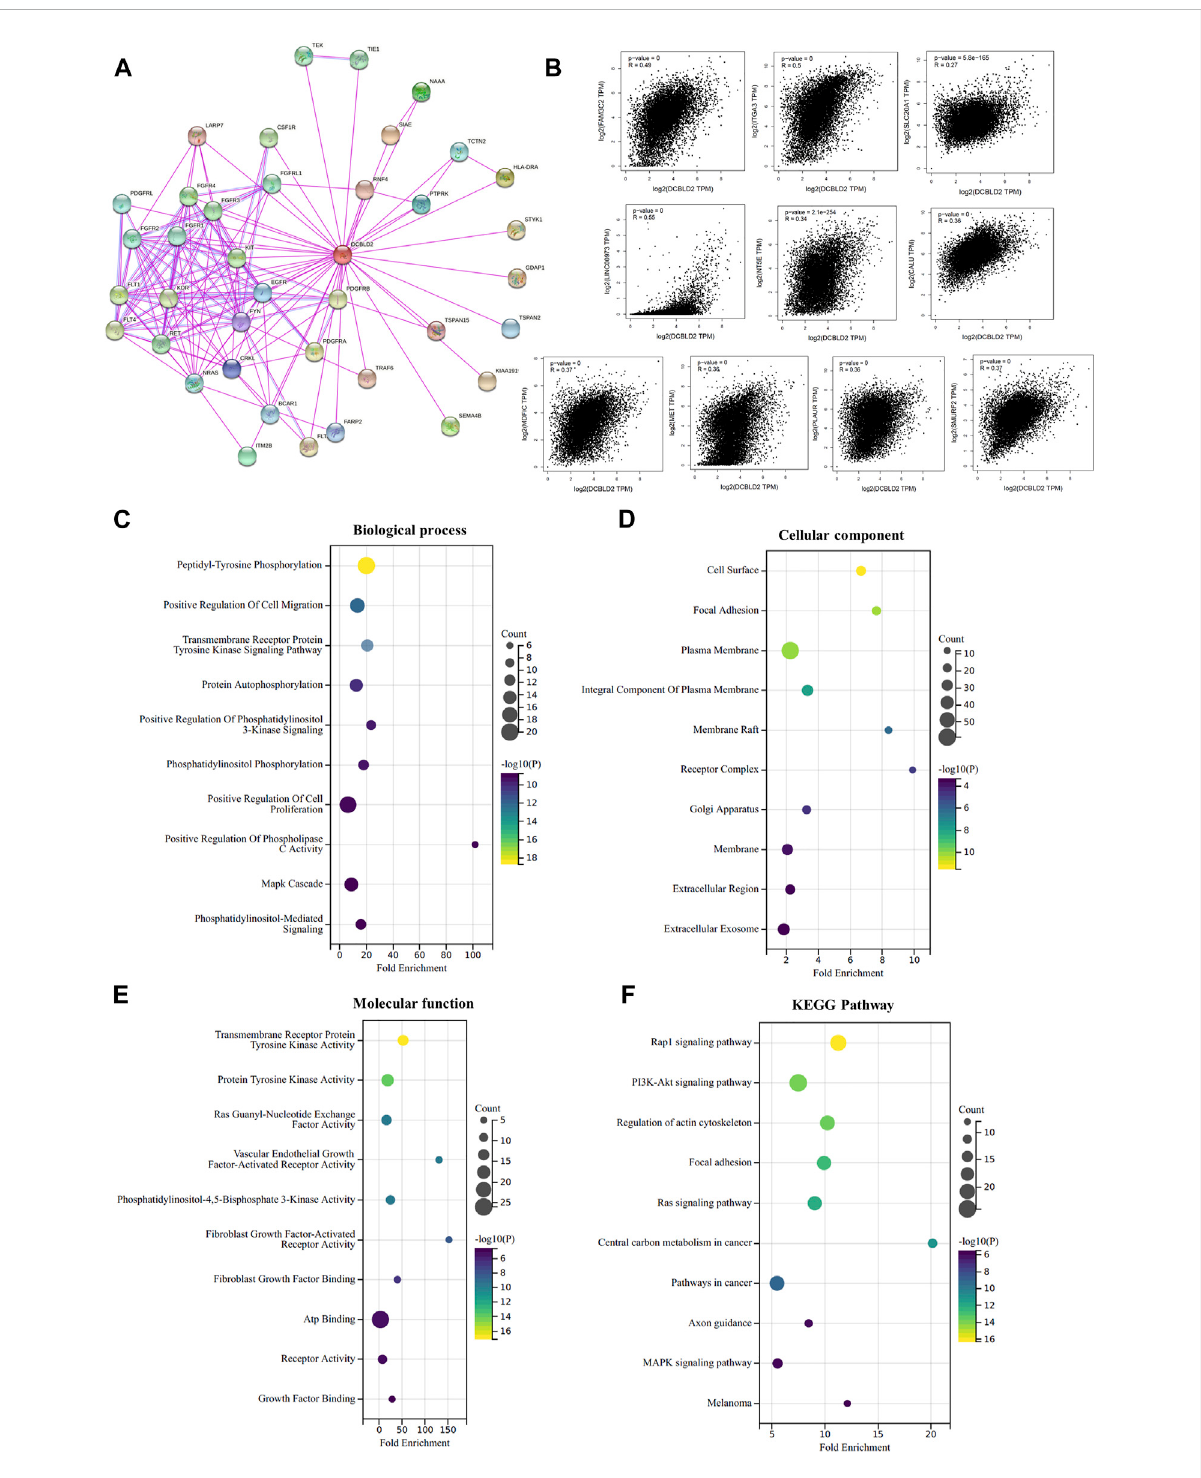
FIGURE 7 Enrichment analysis of DCBLD2-related factors. (A) DCBLD2-binding proteins supported by experimental results were screened using STRING database. (B) Scatter plot of expression correlation analysis of the top 10 DCBLD2 -related genes, including LINC O 0973 , ITGA3 , SLC20A1 , FAM3C2 , NT5E , SMURF2 , MDFIC , CALU , MET , and PLAUR . (C – F) GO enrichment and KEGG pathway analyses were performed based on the combine of DCBLD2-binding proteins and DCBLD2 expression-related genes. Supplymentary Figure S1: The effect of DCBLD2 expression levels on OS, DSS or RFS in patients with colorectal, lung, breast, blood, bladder and ovarian cancers in multiple GSE